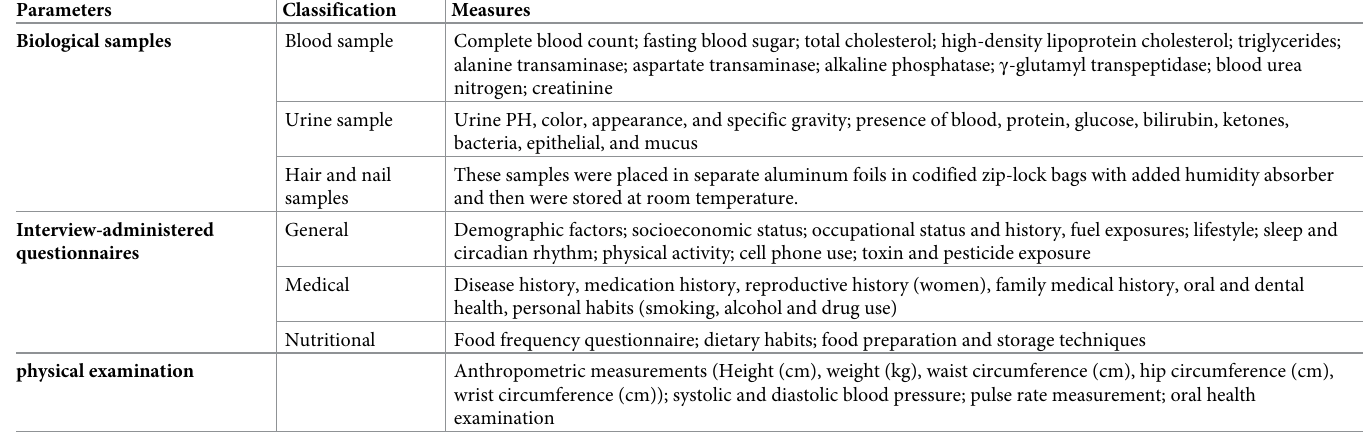
Table 1. Data and samples collected at the baseline phase of the